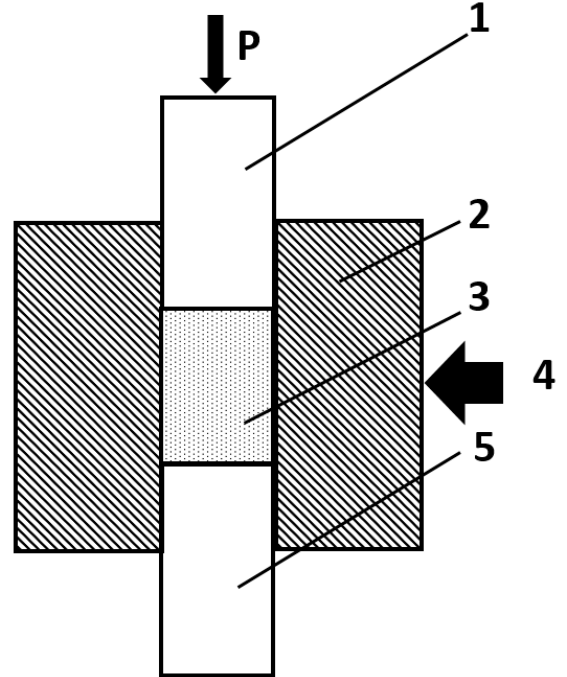
Figure 6. An ultrasonic compaction mold with a radial supply of ultrasound: 1—upper punch, 2—matrix, 3—molding mass, 4—direction of ultrasonic impact (generated by an ultrasonic spot head with the exponential concentrator, magnetostriction oscillator or another type of generator), 5—bottom punch.